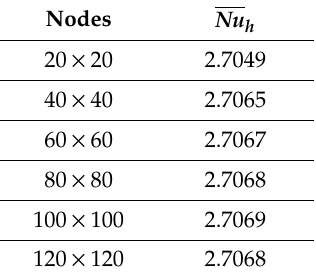
Table 1. Accuracy test for Ra = 10 4 , Pr = 7, ϕ = π / 4, κ = 1, ε = 0.5, Nt = Nb = 0.1, Le = 10, Nr = 0.1. Nodes